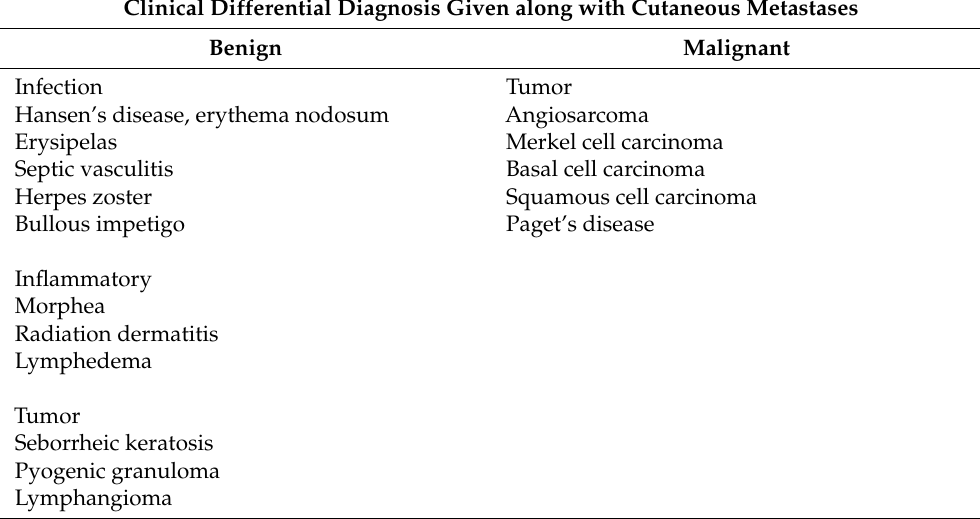
Table 5. Differential diagnoses for cutaneous metastasis provided by clinicians. Clinical Differential Diagnosis Given along with Cutaneous